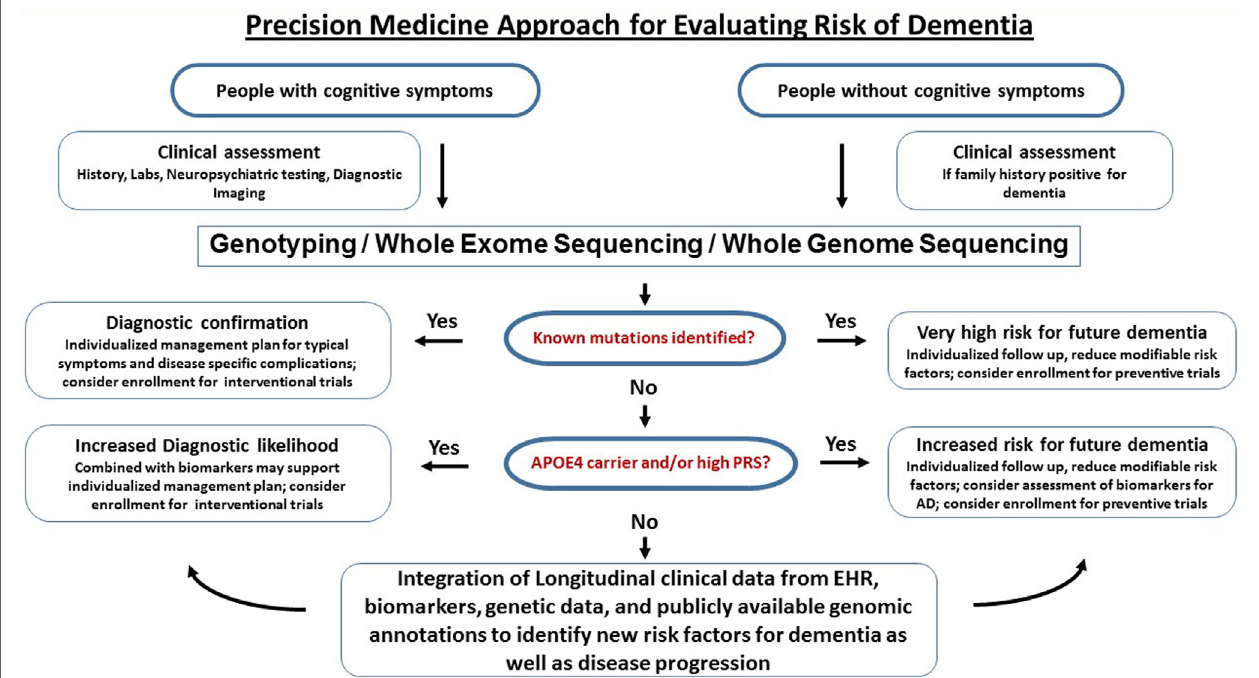
FiGURe 3 | Precision medicine approach for dementia. This is a graphical outline of how genetic and genomic information could be combined and integrated with electronic health records (EHRs) to improve the accuracy of dementia diagnosis and facilitate drug discovery. Middle-aged and older people (e.g., age > 50) are enrolled in an ongoing protocol that includes medical and family history, diagnostic assessment, and access to EHR. For those who have signs of cognitive impairment, genetic testing using either mutation-panels, genotyping arrays, whole exome sequencing or whole genome sequencing depending on the clinical question is performed alongside biomarkers. If a dementia diagnosis is confirmed through genetics and biomarkers, the patients are referred to specialized behavioral and pharmacological intervention and have the option to participate in drug trials. For the majority of subjects who do not have definitive biological findings, a likelihood risk score may be estimated based on the genetic and biomarker profiles. These risk scores may provide support for clinical diagnosis and identify subjects at risk for dementia. The presymptomatic at risk subject may be enrolled in longitudinal studies on prevention and those who never develop dementia despite having high risk may be studied to identify protective